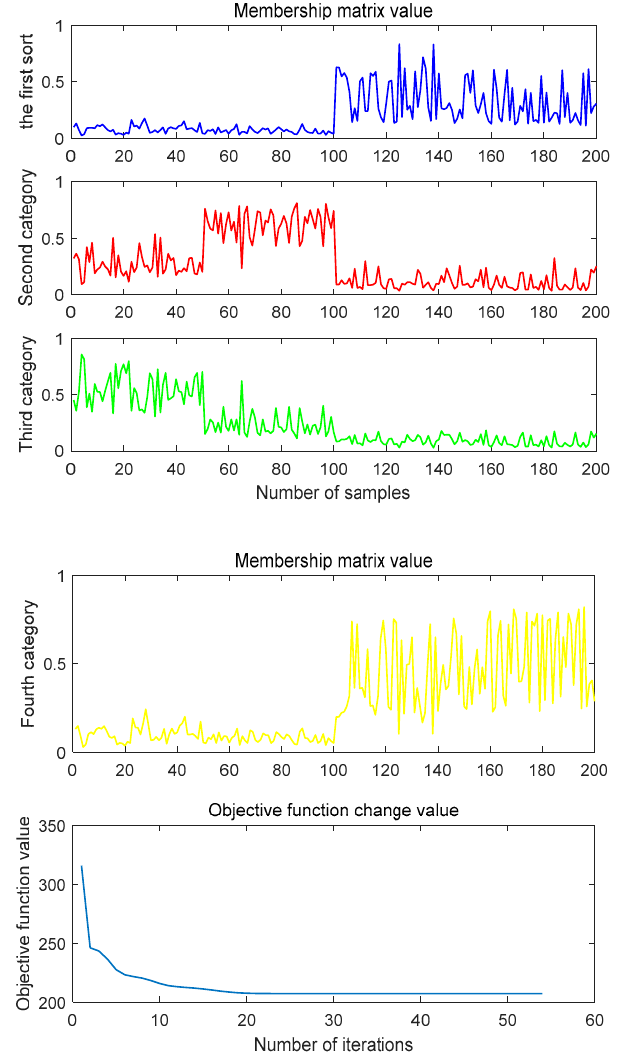
Figure 4. Fuzzy c-means clustering results of four types of users.